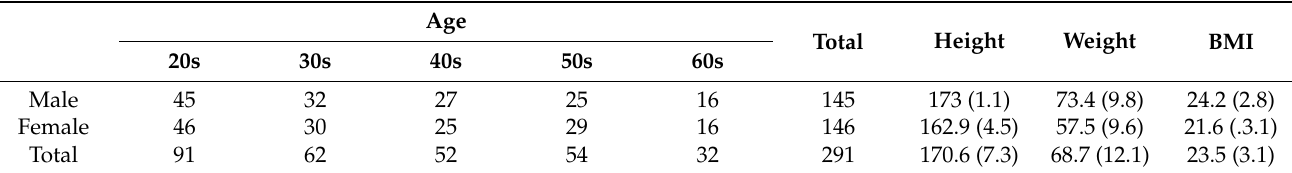
Table 4. The information of participants.